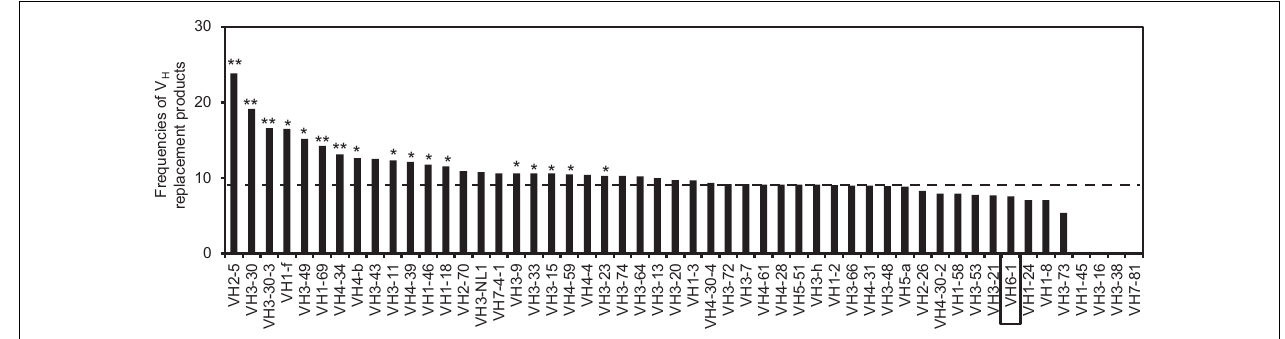
using theV H6-1 gene. ** p < 0.0001, * p < 0.05.The result for IgH genes using theV H6-1 gene is highlighted in the box and the frequency ofV H replacement products in all the IgH genes is indicated by the dashed